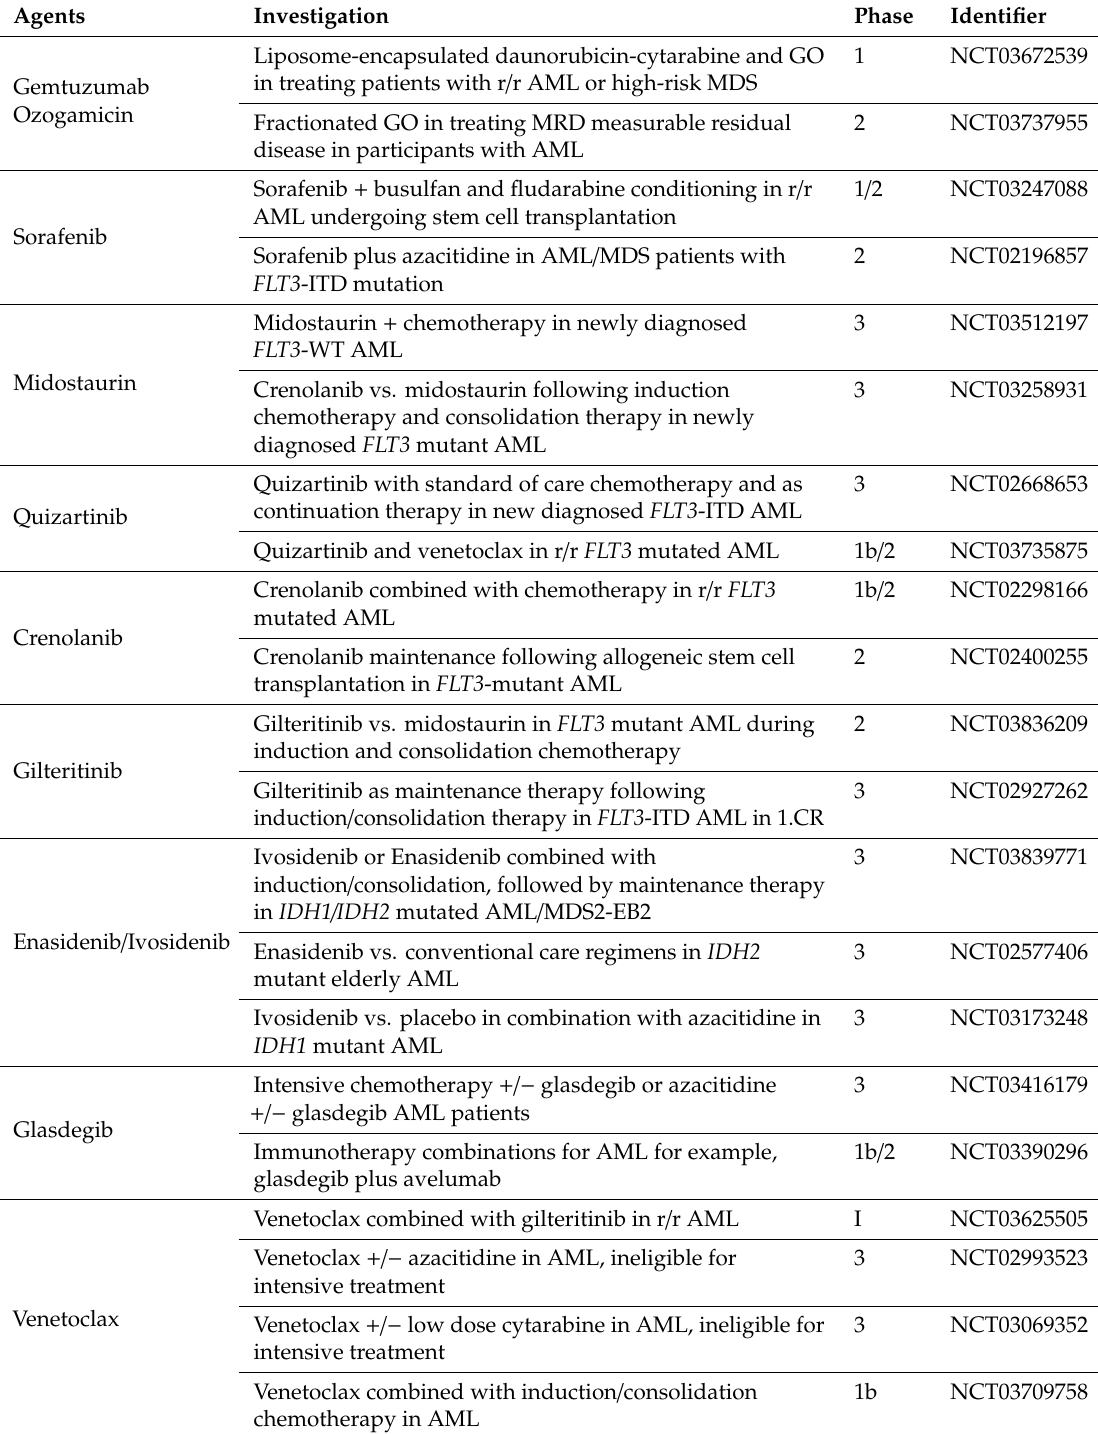
Table 1. Selected trials currently enrolling patients for AML featuring targeted